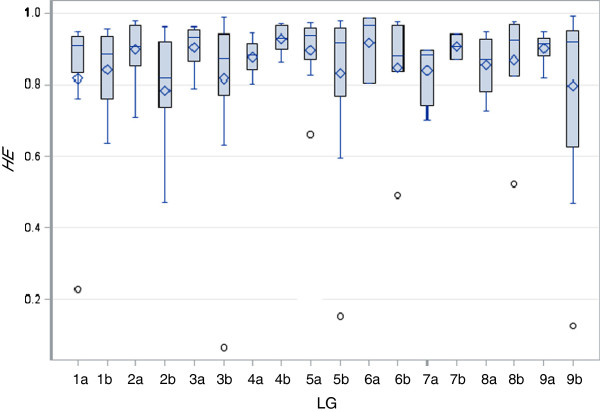
Expected heterozygosity (HE) by linkage group (LG) for 166 simple sequence repeat markers. The box plot showing means (lozenge) and distribution of heterozygosity values for different LGs.